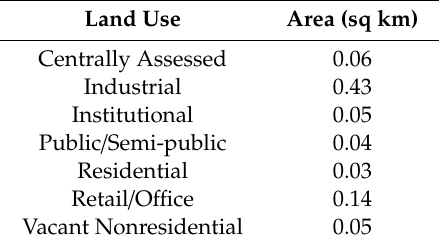
Table 5. Area statistics of NBI-derived object, referencing FGDL data.